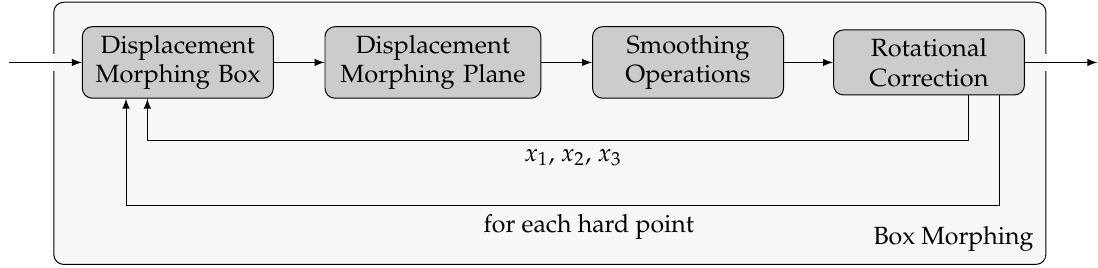
Figure 4. Detailed Box Morphing process from Figure 2.